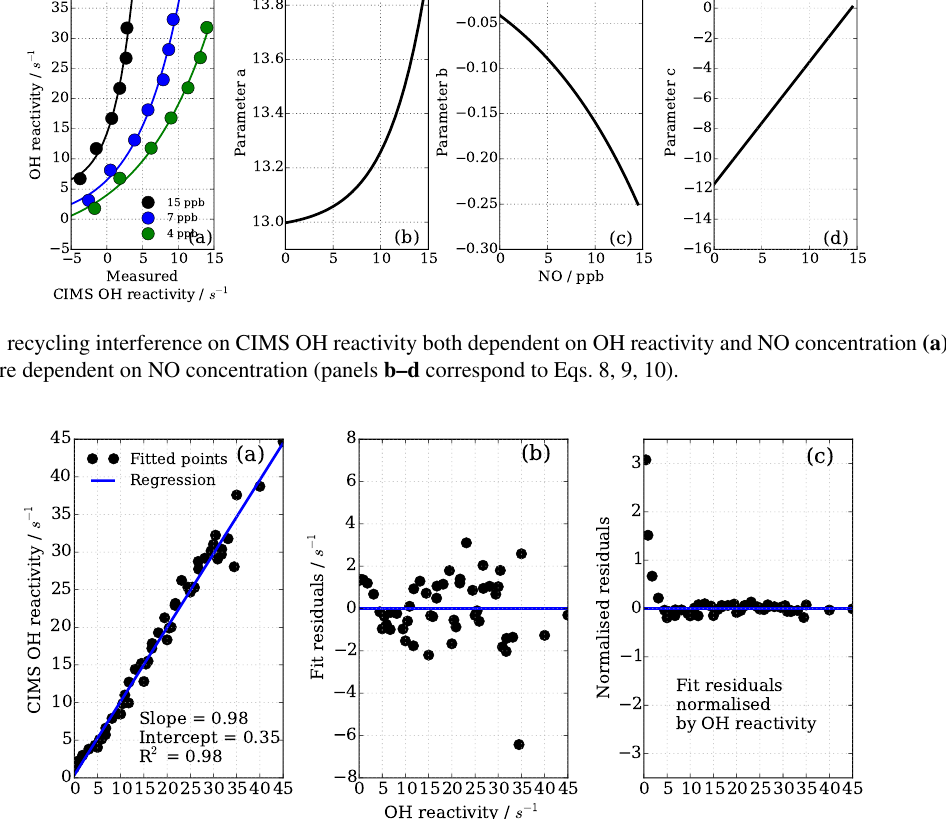
Figure 10. Performance of the eight parameter correction function (Eqs. 7–10), (a) goodness of fit of correction function, (b) fit residuals and (c) fit residuals normalized by OH